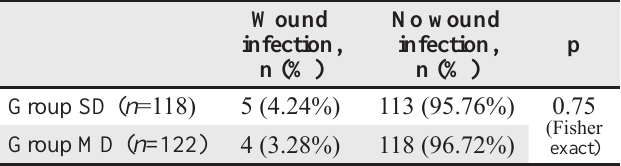
Table 1 : Wound infection between two groups